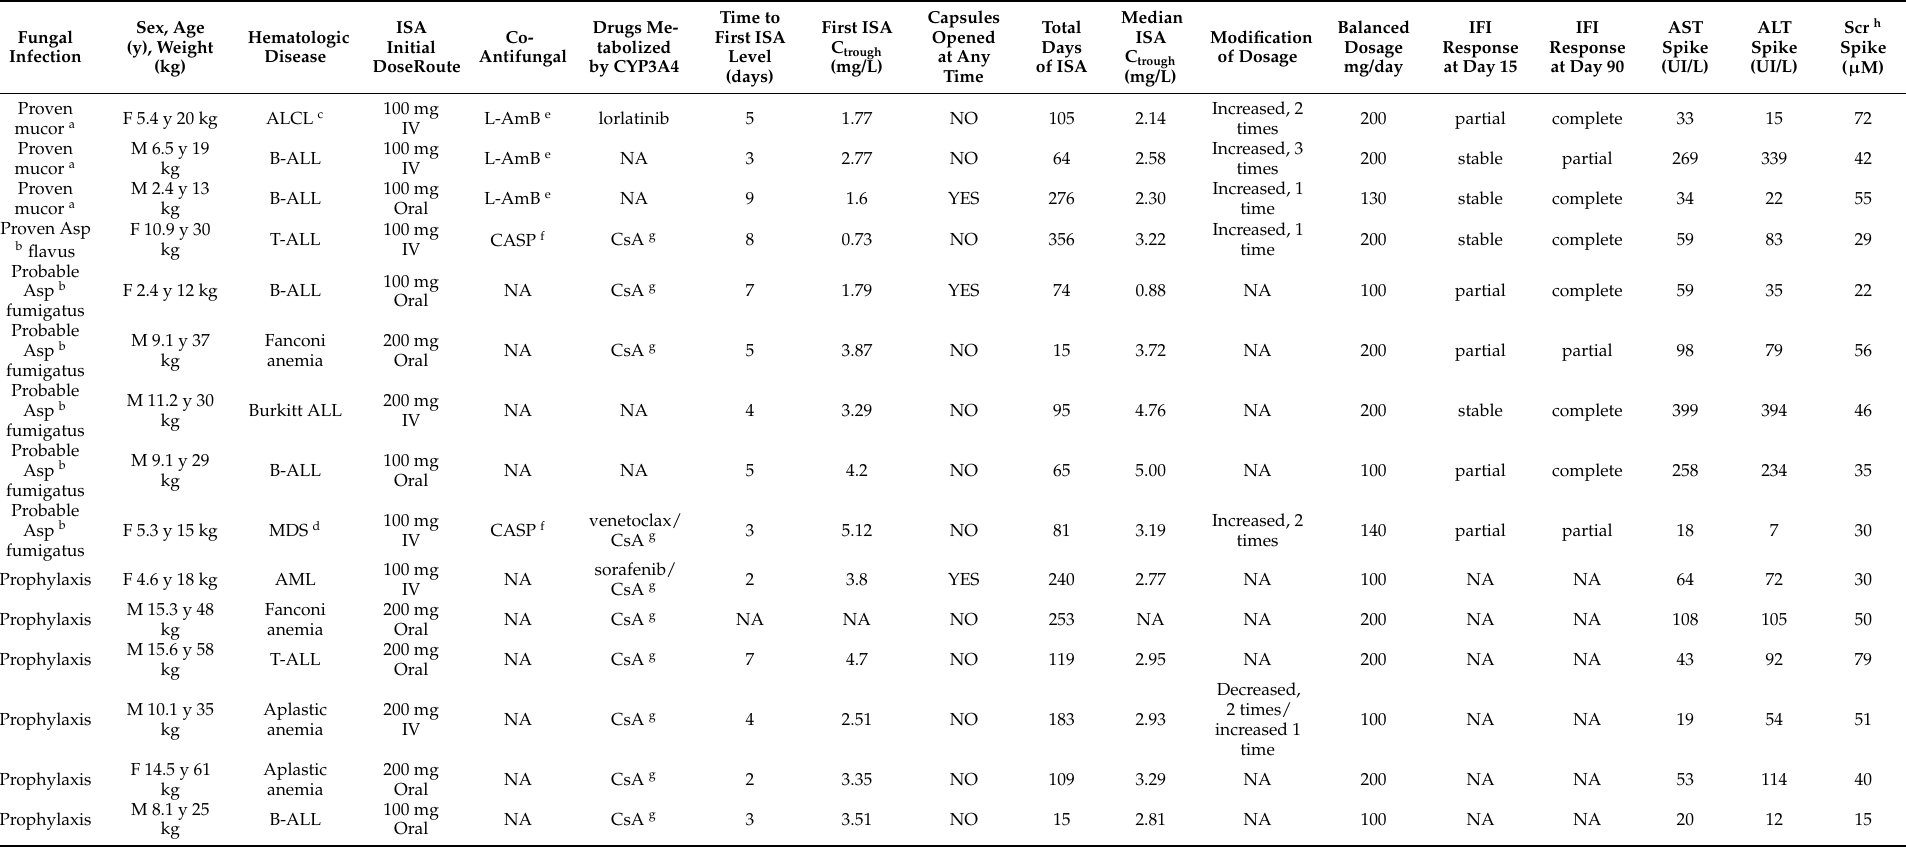
Table 1. Overview of patient